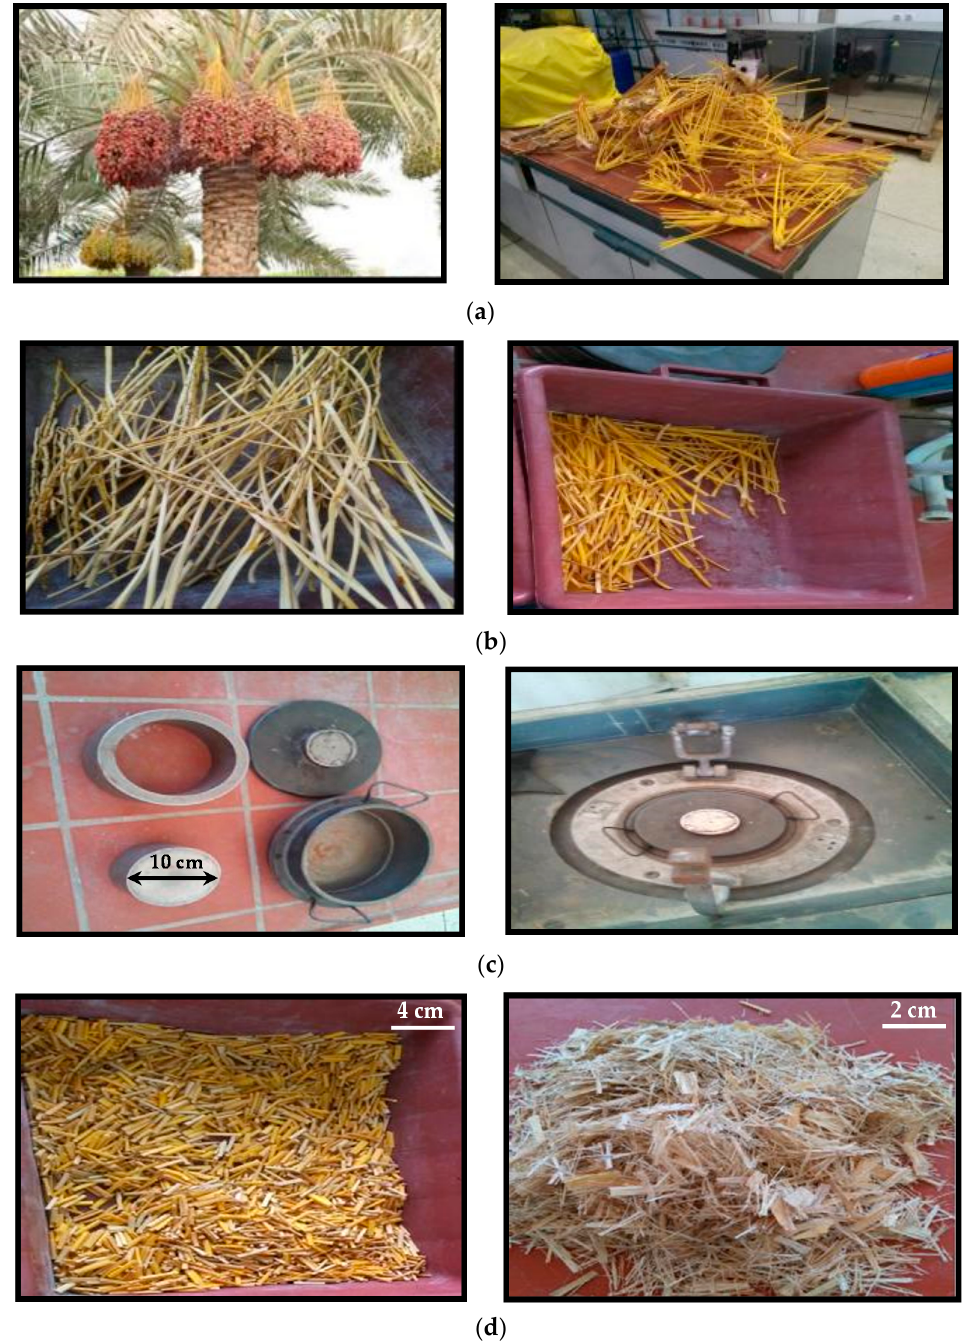
Figure 2. Different extraction steps of palm fibers. ( a ) Salvaged date stems; ( b ) cut palm stalk; ( c ) mill components; ( d ) palm stem fibers.